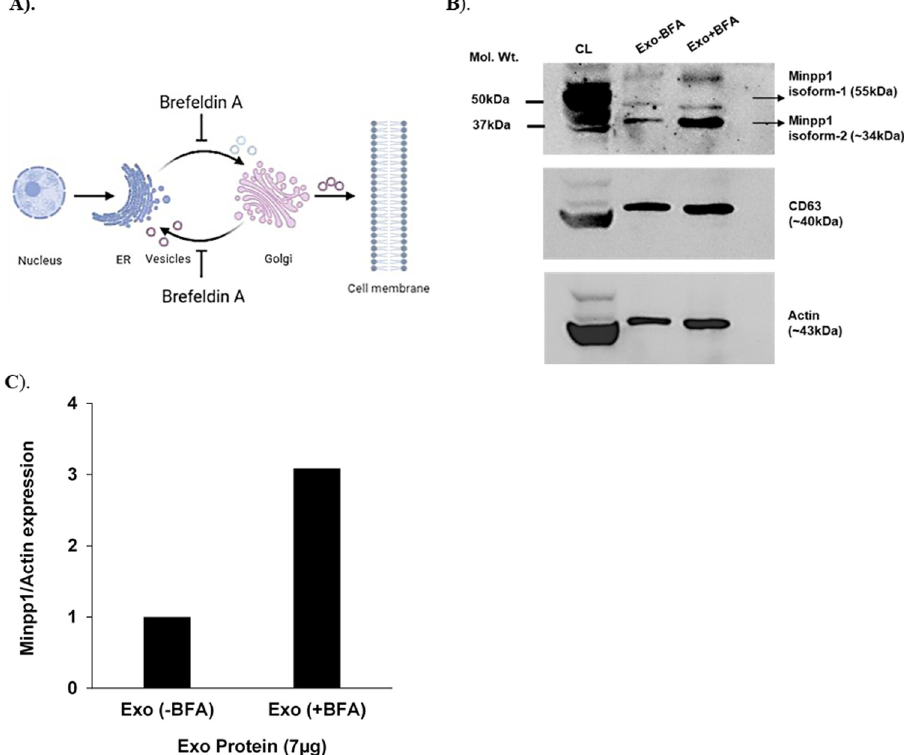
Fig 9. Analysis of Minpp1 isoform-2 expression in BFA induced MCF-7 exosomes: A) . Mechanistic illustration of protein trafficking inhibitor-BFA, B) . Western blot analysis of exosomes (Exo) isolated from BFA (10 μ g/mL, 24h) treated and untreated MCF-7 cells conditioned media, pre-enriched by sequential centrifugation. An equal amount of proteins (7 μ g) from both control and BFA-treated Exo were loaded. Probing was done by; anti-Minpp1 antibody (Fabgennix Inc.) that also binds to Minpp1 isoform-2, anti-Exo biomarker: CD63 antibody (Santa Cruz Biotech Inc.) and, β -Actin antibody (Santa Cruz Biotech Inc.) at 1:1000 dilution in blocking buffer, CL; cell lysate (40 μ g protein). Shown blots are a representative result of three independent experiments (n = 3). C) . A comparative analysis of Minpp1’s expression percentage) between BFA treated and untreated Exo sample. A more than 3-fold increase in Minpp1 isoform-2 secretion in EVs from BFA treated cells was